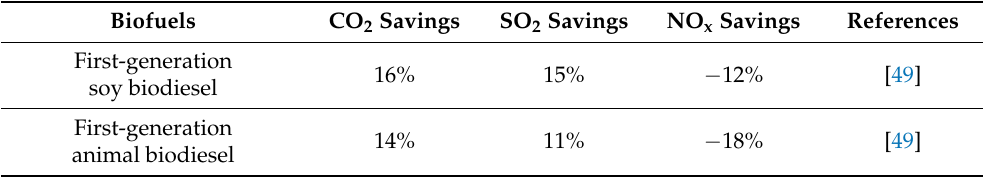
Table 4. GHG emission savings of the different generations of